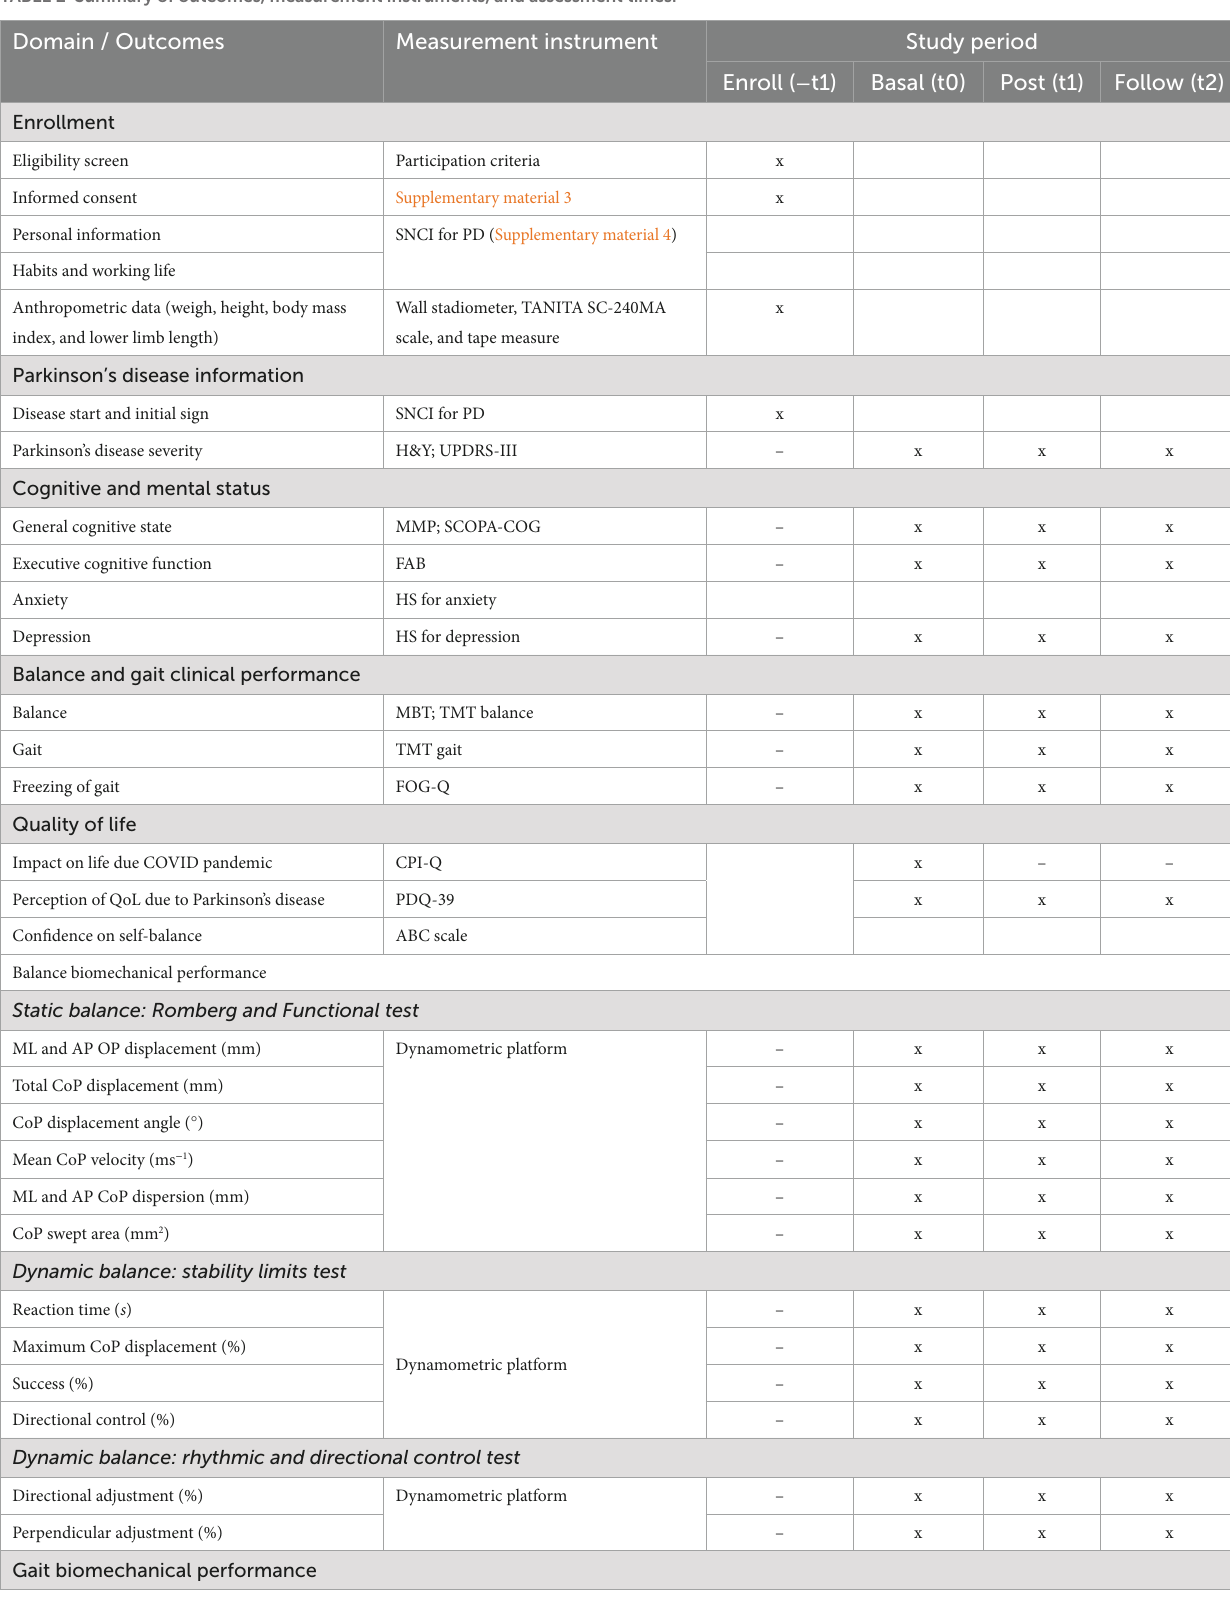
TABLE 2 Summary of outcomes, measurement instruments, and assessment times. Domain /